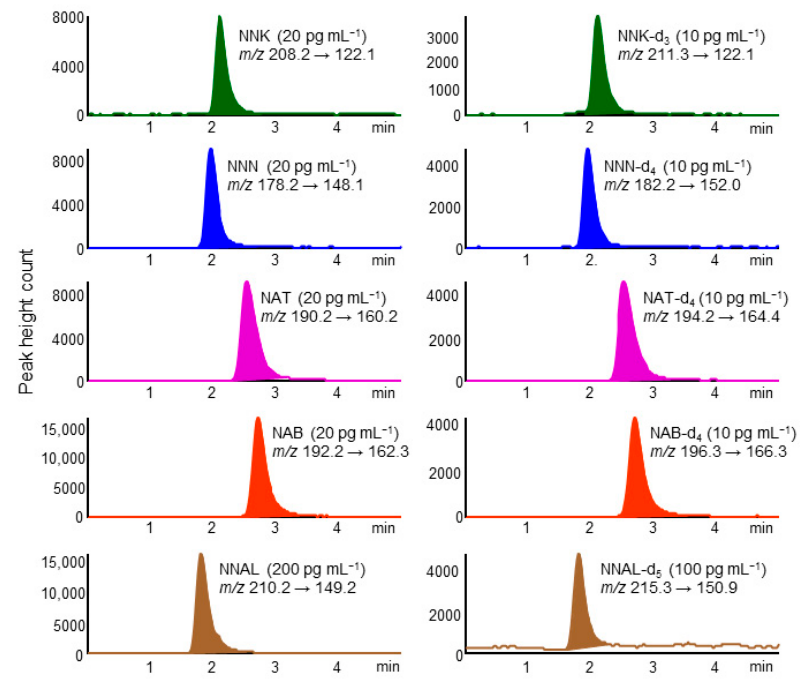
Figure 1. Multiple reaction monitoring (MRM) chromatograms of standard tobacco-specific ni- trosamines (TSNAs) and their stable isotope-labeled compounds. In-tube solid-phase microextraction (SPME) LC–MS/MS conditions are described in the Experimental